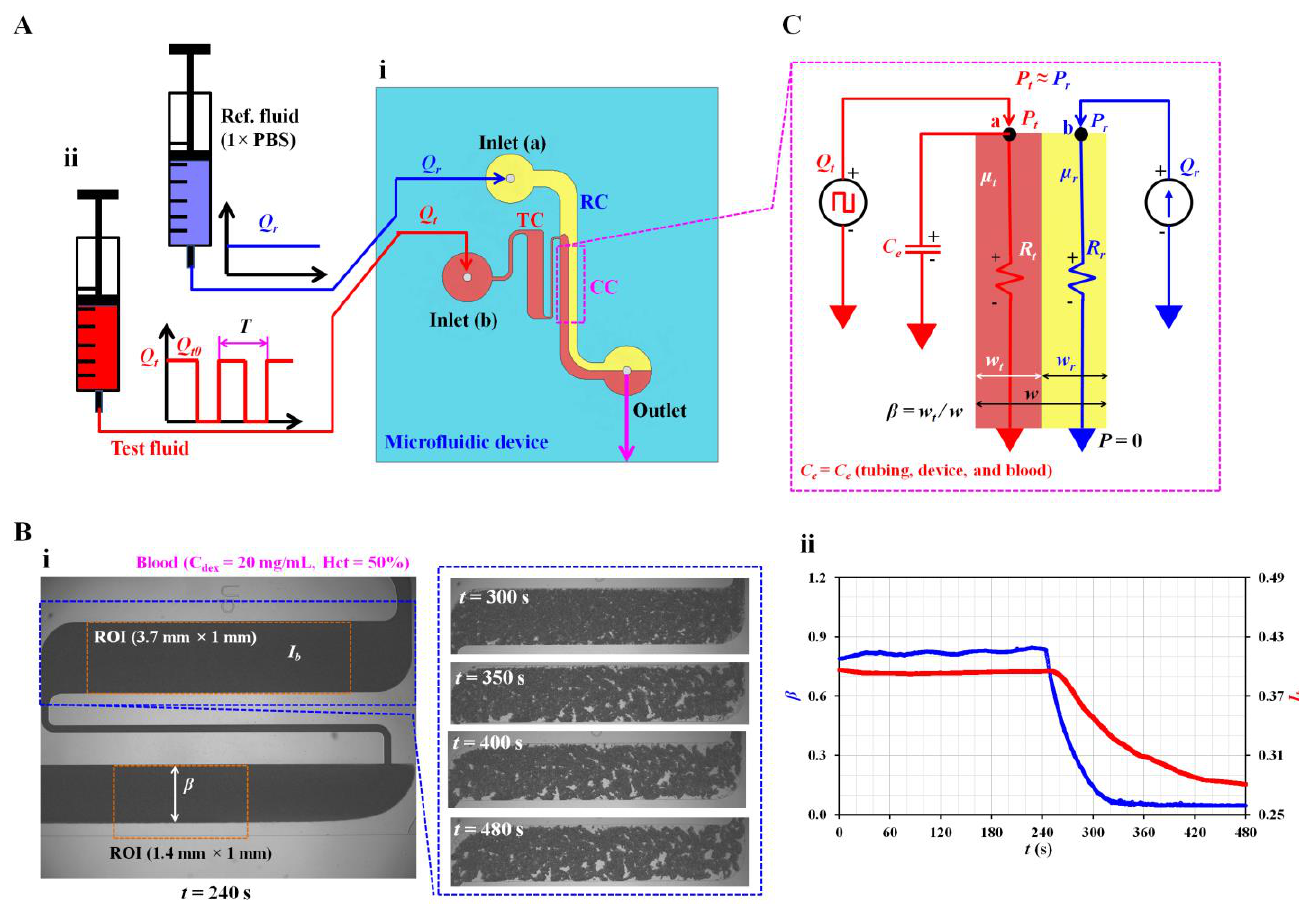
Figure 1. Proposed method for quantifying three haemorheological properties by analysing dynamic varying blood flow. ( A ) Schematic of the experimental setup, including a microfluidic device and two syringe pumps. ( i ) Microfluidic device with two inlets (a, b), an outlet, a reference fluid channel (RC), a test fluid channel (TC), and a coflowing channel (CC). ( ii ) Syringe pumps to supply test and reference fluids, respectively. Flow rate of reference fluid set to a constant value of Q r . Flow rate of test fluid ( Q t ) set to square-wave profile (i.e., maximum flow rate: Q t0 , minimum flow rate: 0, period: T ). ( B ) Quantification of microscopic image intensity of blood flow and interface in the coflowing channel. ( i ) Quantification of microscopic image intensity ( I b ) and interface ( β ). The right side panels show the variations in microscopic blood captured at a specific time ( t ) ( t = 300, 350, 400, and 480 s) after the syringe pump was turned off. ( ii ) Temporal variations in I b and β . ( C ) Discrete fluidic